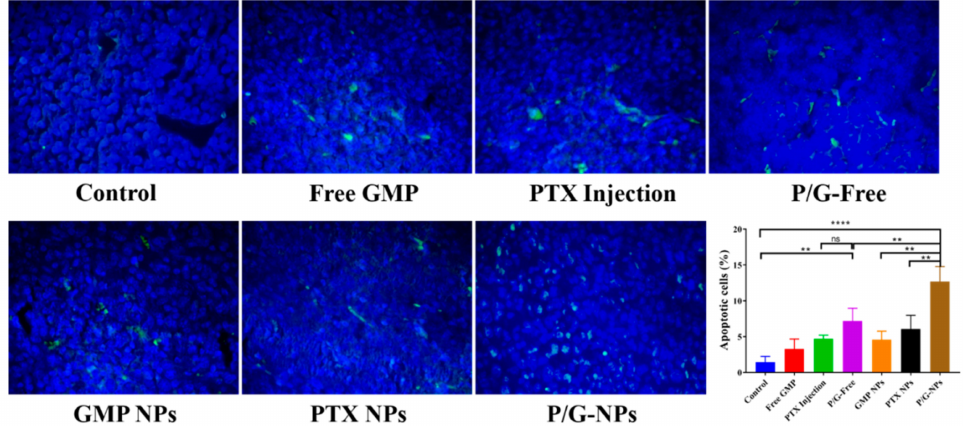
Figure 8. Effects of different treatments on the induction of apoptosis in tumors (400 × ), and the quantitative results of apoptotic cells expressed as the percentage of total cell numbers in tumors, **** p < 0.0001, ** p < 0.01, ns: not